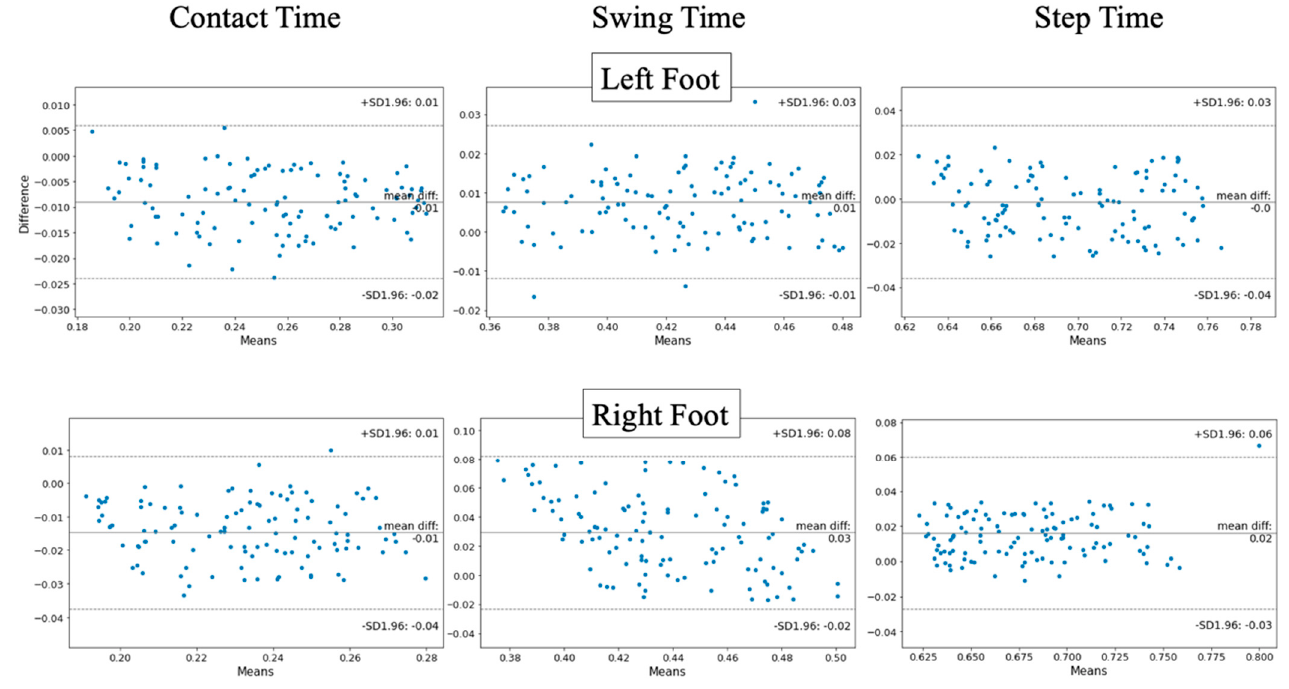
Figure 4. Bland–Altman plots illustrating the mean error between BlazePose estimation and reference standard 3D motion tracking data streams for contact time, swing time, and step time between left and right feet.